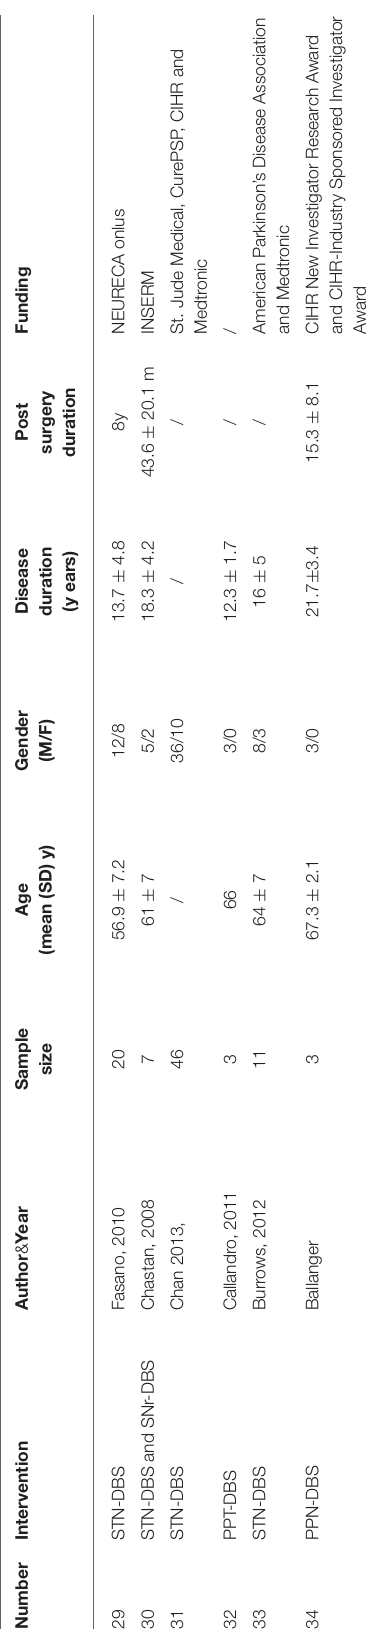
results of the NMA show that GPi-DBS, STN-DBS, and PPN- DBS are superior to the baseline [GPi-DBS: –0.79(–1.2, –